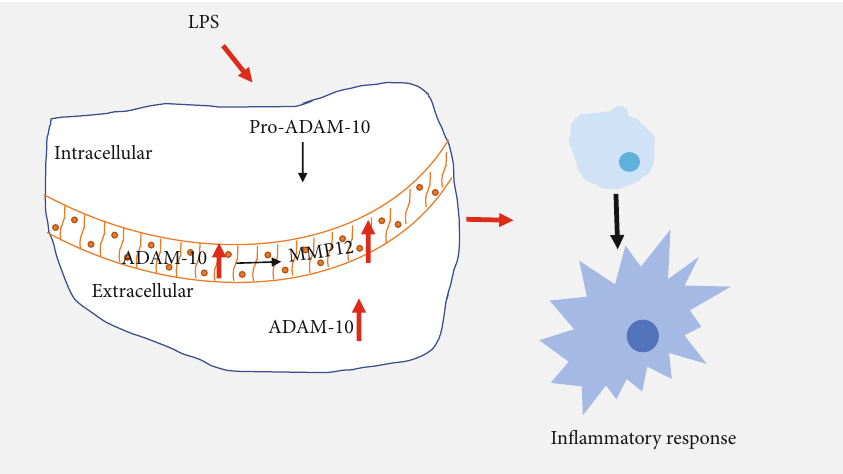
Figure 5: Mechanism of A disintegrin and metalloprotease 10 (ADAM-10) regulation of matrix metalloproteinase 12 (MMP-12) in lipopolysaccharide-promoted proliferation- (LPS-) induced macrophages. LPS promotes macrophage in fl ammatory responses. Intracellular pro-ADAM-10 is processed into ADAM-10. Additionally, ADAM-10 protein secretion is increased. In this process, ADAM- 10 promotes MMP-12 expression, which is jointly related to the LPS-induced in fl ammatory